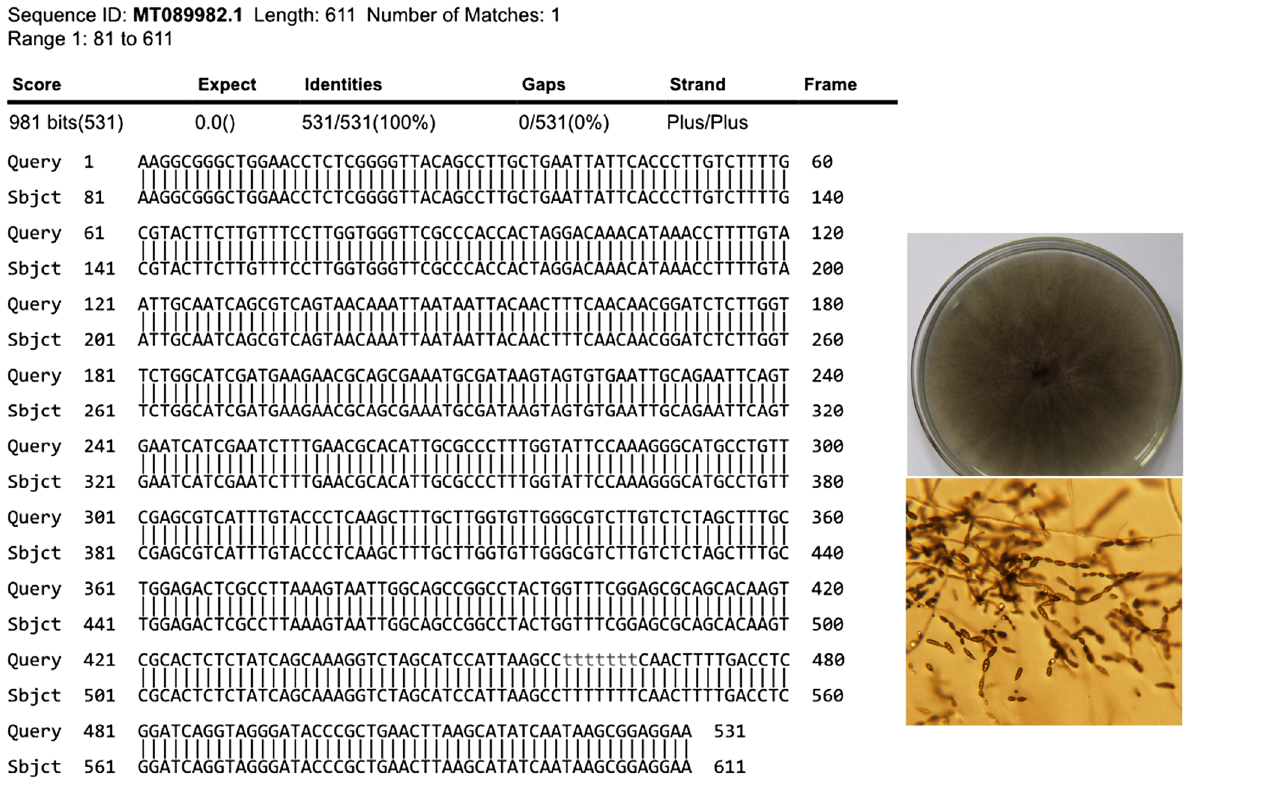
Figure 5. Molecular identification and BLAST comparison of Alternaria spp. on black spots of grains from three plates for each of the 10 ecological regions. A plate containing 10 mildewed grains of Bayou 13 cultured on PDA medium for 5 days.